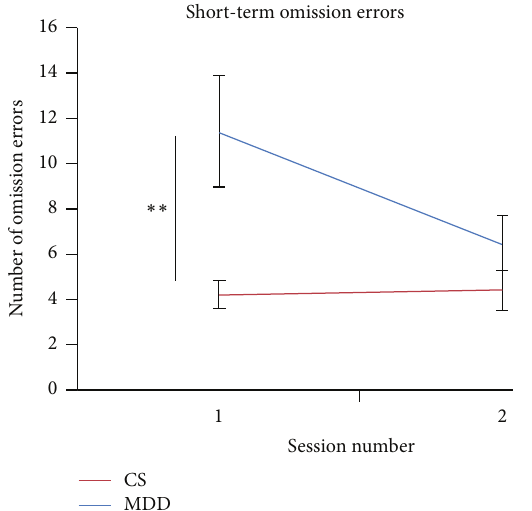
Figure 2: Adjusted group means and standard error of short-term omission errors from the Sustained Attention to Response Task for clinicallydiagnosedMajorDepressiveDisorder(MDD)patientsand control subjects (CS). The significance differences reported relate to the post hoc analysis of interaction effects, ∗∗ 𝑝 < 0.01 .